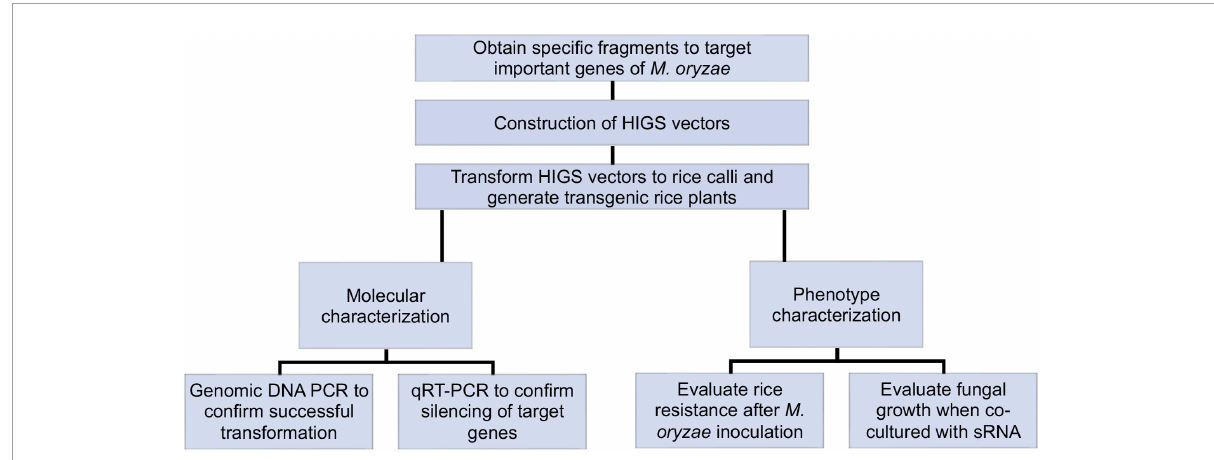
FIGURE1 Schematic overview of host-induced gene silencing (HIGS) experimental workflow. Specific fragments were chosen and inserted into HIGS vectors to target important genes of Magnaporthe oryzae . Transgenic rice was generated by transforming HIGS vectors into rice calli. Transgenic rice was then subjected to molecular and phenotype characterization. Positive transgenic rice was first confirmed through genotyping. Then transgenic rice was inoculated with M. oryzae for fungal resistance evaluation. Relative transcription of fungal target genes from infected transgenic rice leaves was analyzed through qRT-PCR. Furthermore, M. oryzae was co-cultured with sRNA derived from target genes for fungal growth